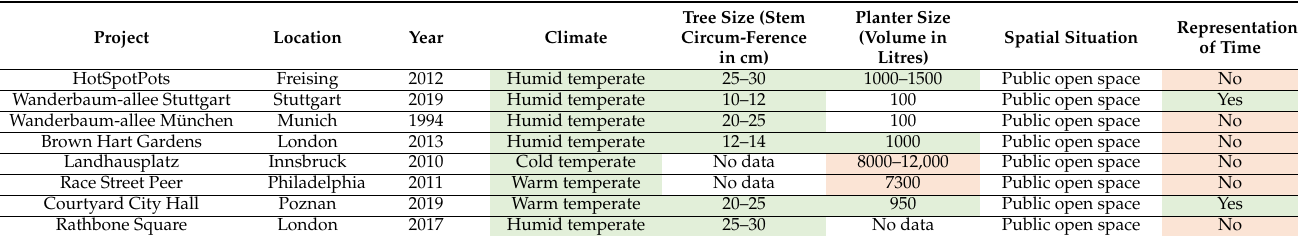
Table A1. Thirty-two found projects, fulfilled criteria highlighted in green, missed criteria highlighted in